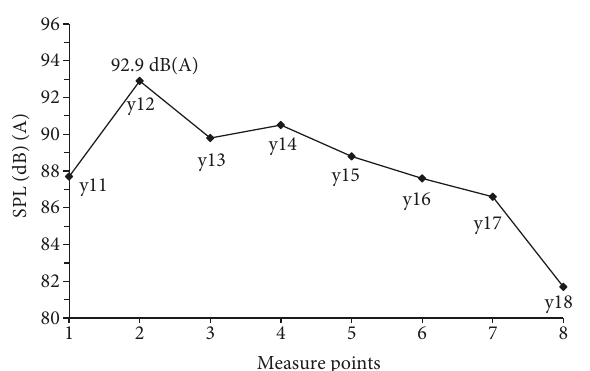
Figure 16: Distribution of noise levels of noise points which are 7.5m far and 3.5m high.